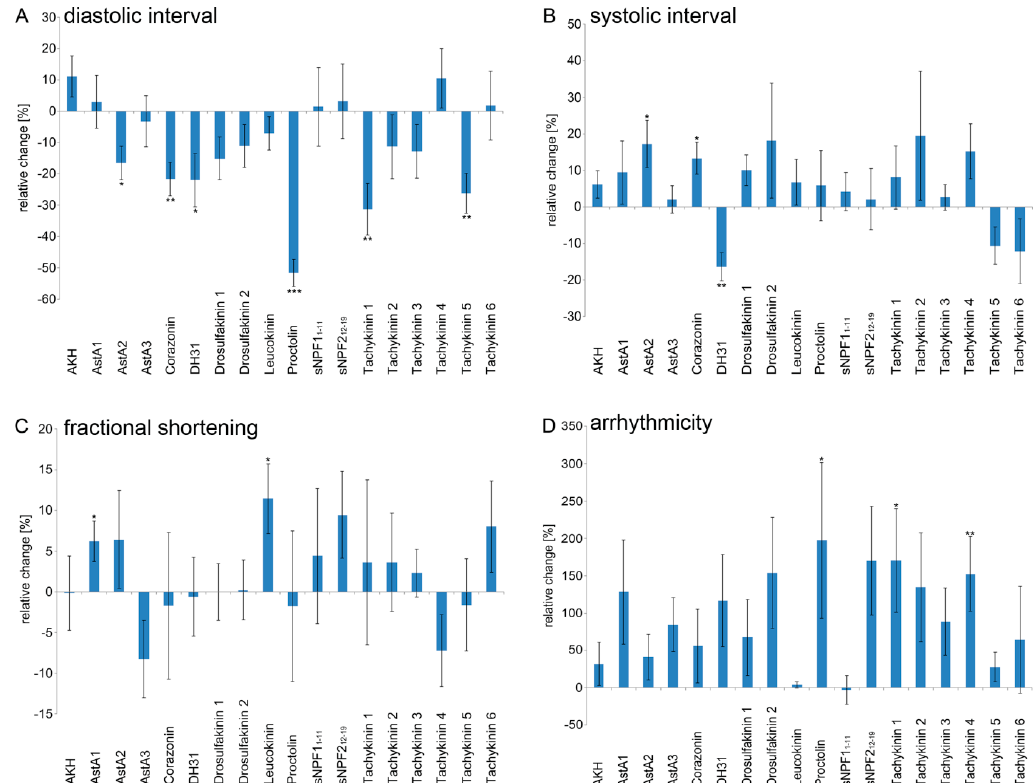
Figure 3. Diastolic and systolic intervals, fractional shortening and rhythmicity are modulated by peptide signalling in semi-intact Drosophila larvae. Individual effects of the tested peptides (1 × 10 − 7 M) on: ( A ) diastolic interval; ( B ) systolic interval; ( C ) fractional shortening; and ( D ) rhythmicity. Data are presented as mean values (± S.E.M.) of the relative changes in the respective parameters in relation to the individual control preparations (prior to peptide application). A minimum of ten animals per peptide were measured. Significance levels are indicated by asterisks (paired sample Student´s t -test, * p < 0.05; ** p < 0.01; *** p < 0.001).